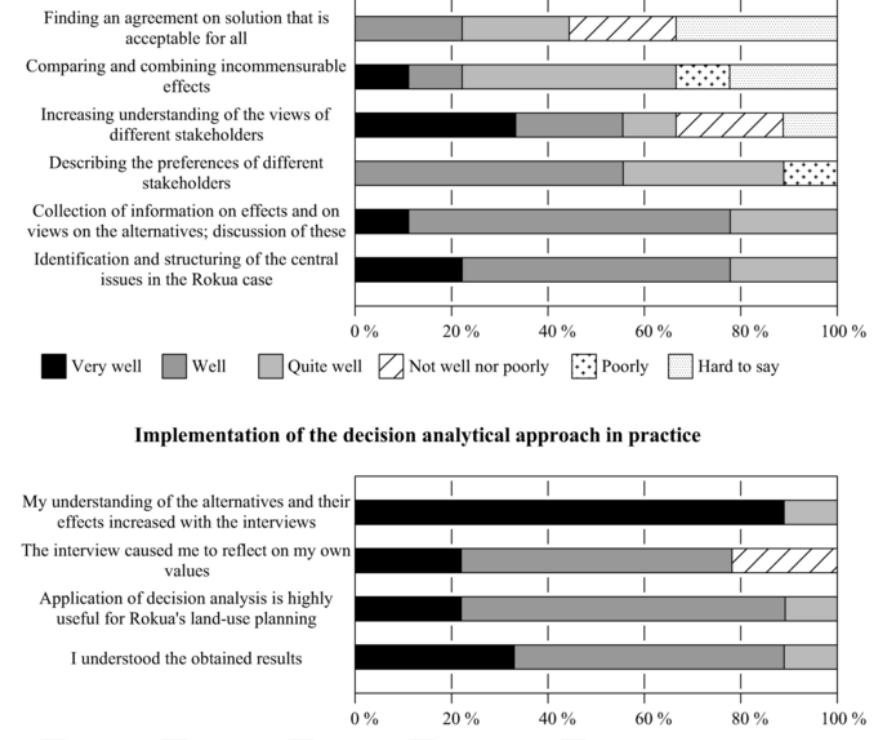
Figure 8. Results of the feedback questionnaire among the participants of the MCDA process.